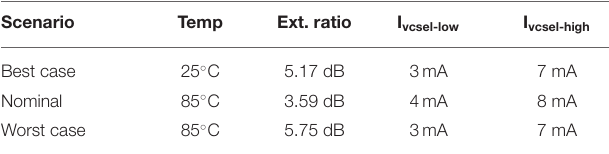
TABLE 4 | Vertical-cavity surface-emitting laser driver design scenarios. TABLE 5 | Transimpedance amplifier design parameter